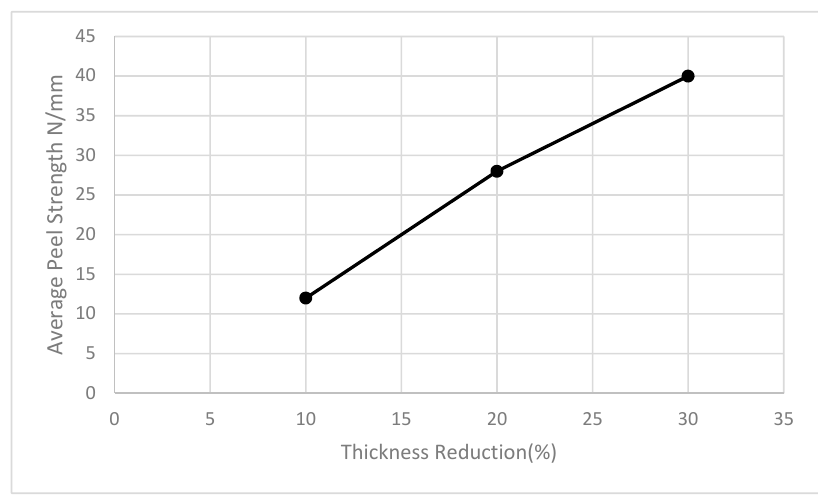
Figure 11. Variation of the average peeling force of Al/Cu bimetallic laminates versus total thickness reduction ratios at 300 °C.